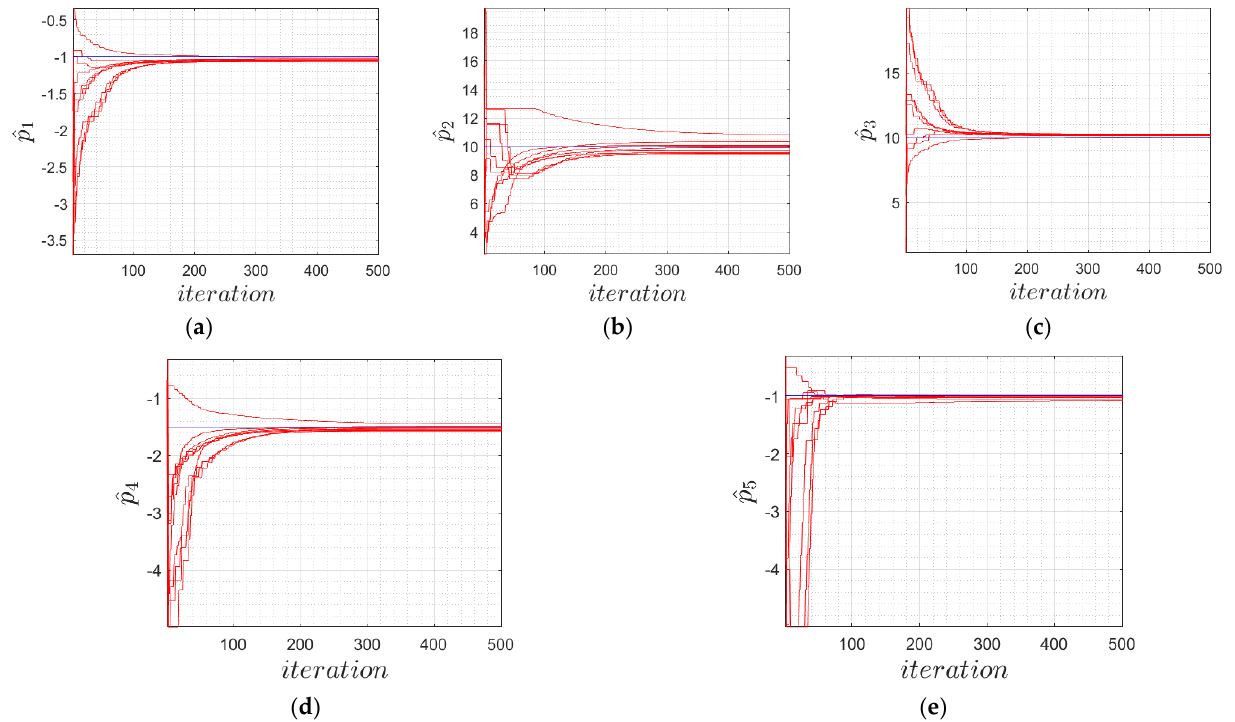
Figure 3. Convergence of the estimated parameters using line search-based nonlinear optimization algorithm. ( a ) 𝑝̂ 1 con- vergence, ( b ) 𝑝̂ 2 convergence, ( c ) 𝑝̂ 3 convergence, ( d ) 𝑝̂ 4 convergence, ( e ) 𝑝̂ 5 convergence.